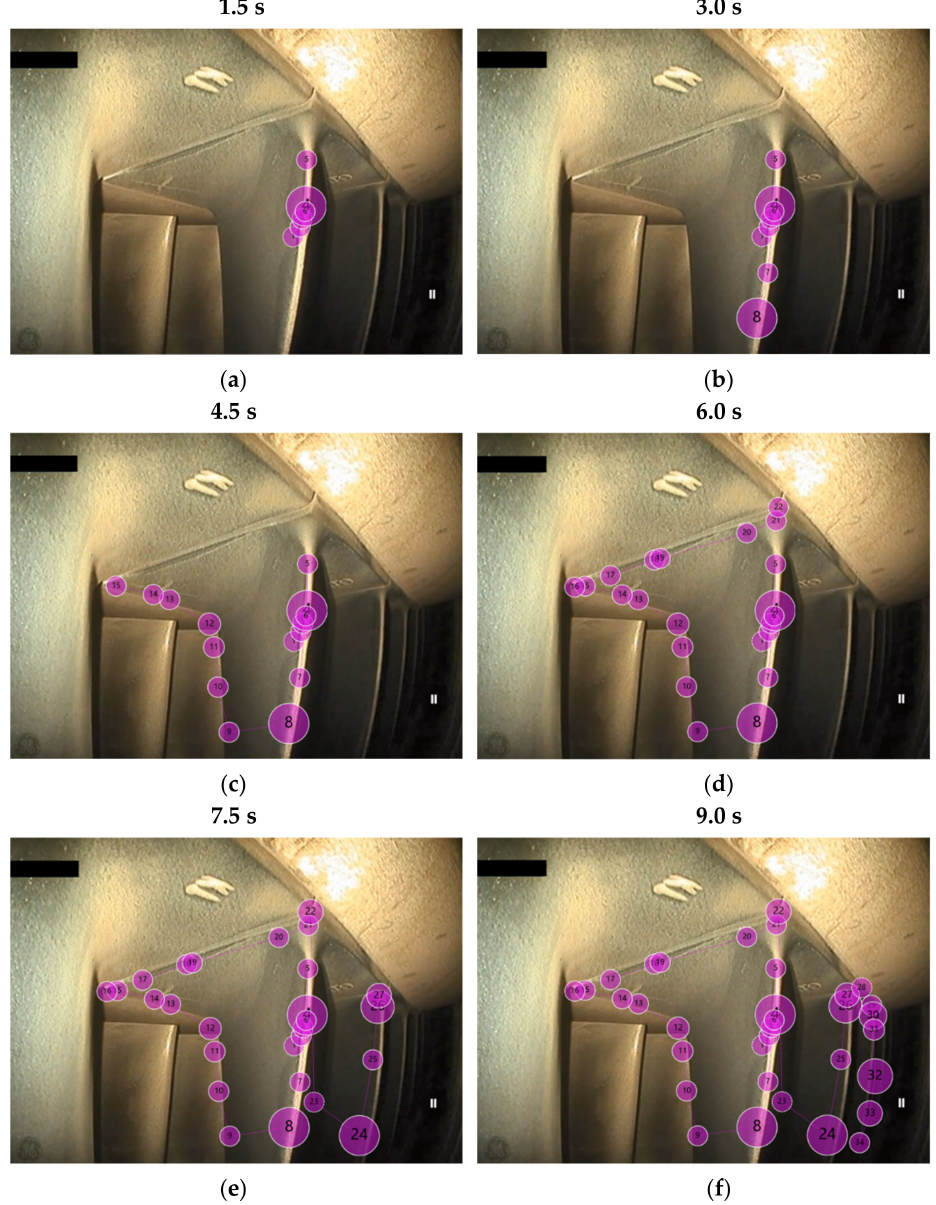
Figure 18. Gaze plot of an experienced borescope inspector in 1.5-s